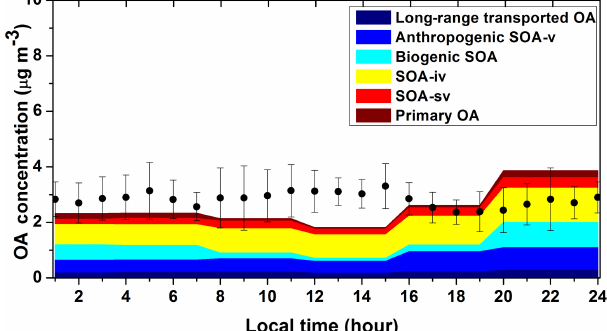
Figure 4. Average diurnal profile of OA at the ground level in San Pietro Capofiume (one-bin case, as an example). With dark blue we represent the OA from long-range transport, with blue the anthropogenic SOA produced during the oxidation of anthro- pogenic VOCs (aSOA-v), with cyan the biogenic SOA (bSOA), with yellow the SOA from oxidation of intermediate volatility com- pounds (SOA-iv), with red the SOA from the oxidation of semi- volatile OA (SOA-sv), and finally with dark red the fresh primary organic aerosol (POA). The ground AMS measurements are shown with black symbols and the error bars correspond to 1 standard de-